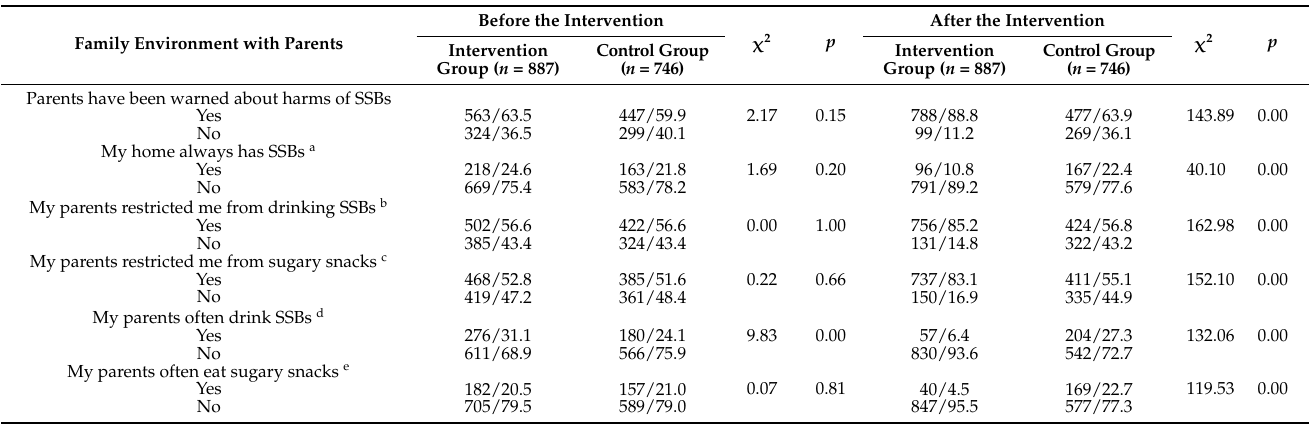
Table 4. Family environment with parents and at home